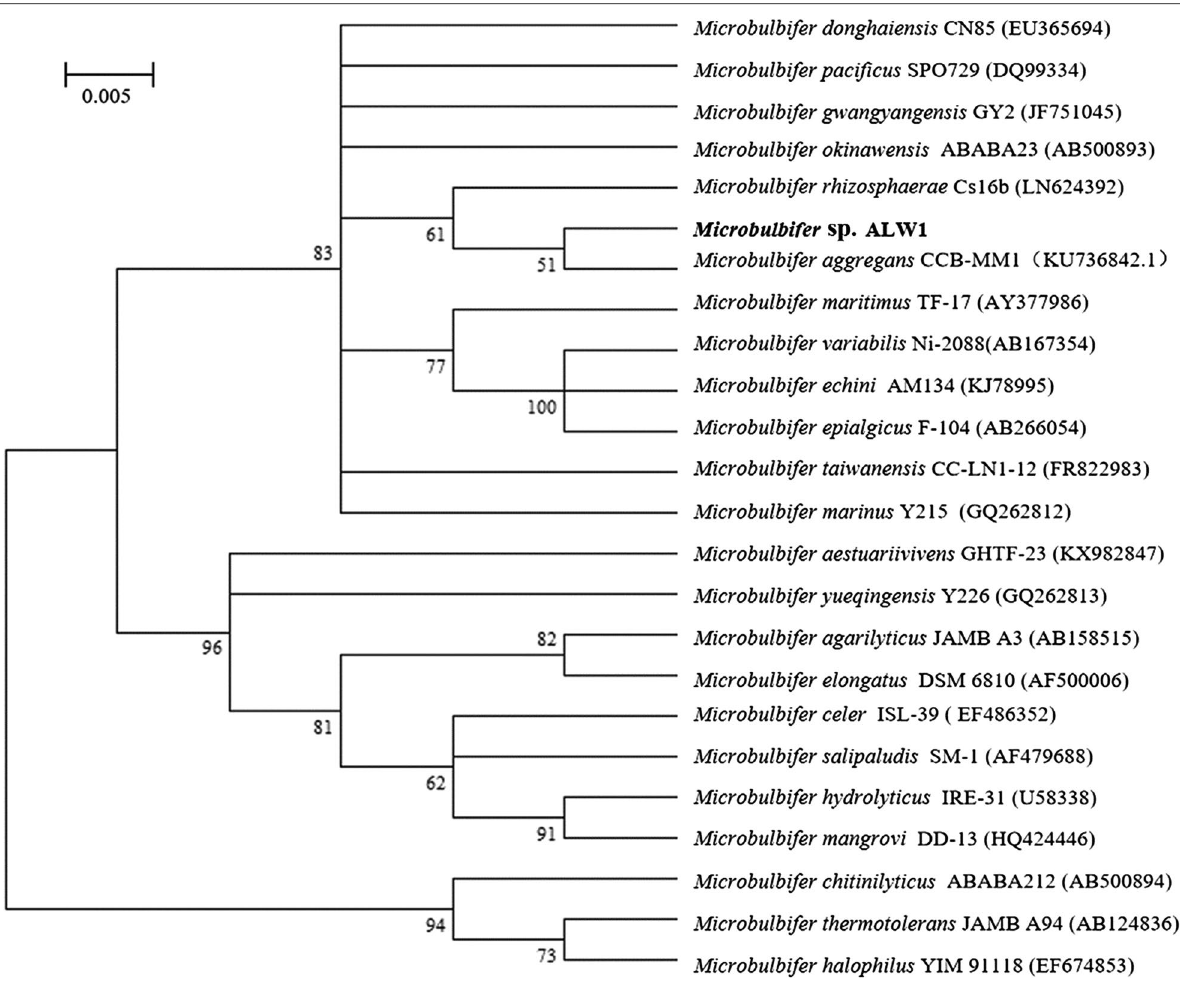
Fig. 2 Phylogenetic tree analysis for strain ALW1 and its closely related species within genus Microbulbifer . Numbers at the nodes indicate